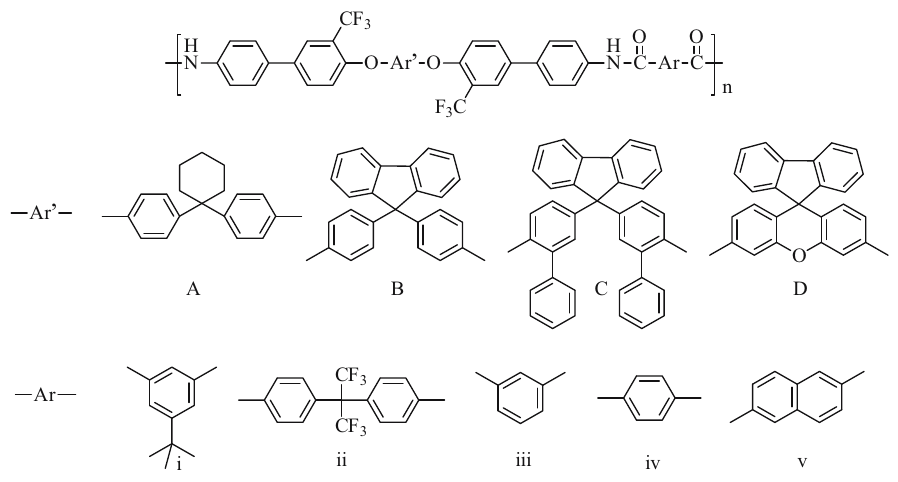
Figure 10: Di ff erent bulky cardo groups incorporated to modify the polyamides structures ( 72 – 74 )